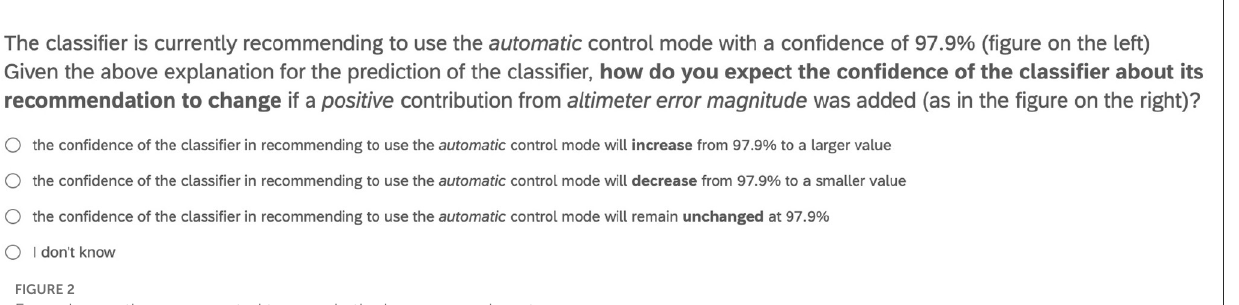
FIGURE2 Example question as presented to users in the human